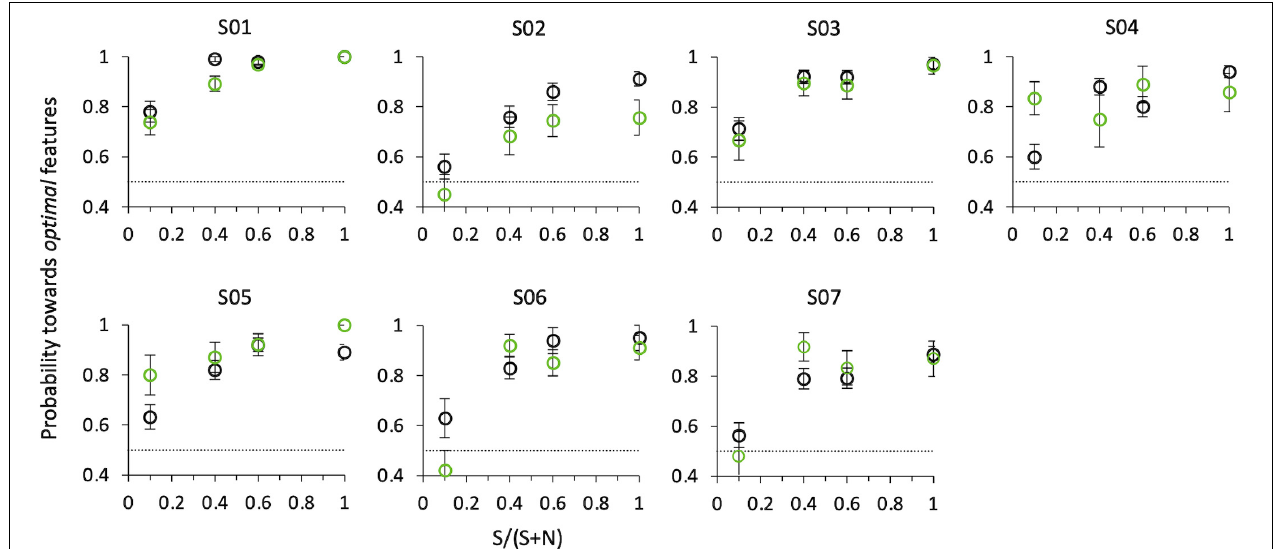
FIGURE 8 | Probability of selecting the target as a function of SNR at angle 0 ◦ . Black circles: psychophysical results (button-press); green circles: eye movements results. Data from individual observers (weighted means with their errors). The dashed line indicates the guessing level for this task (0.5 probability).